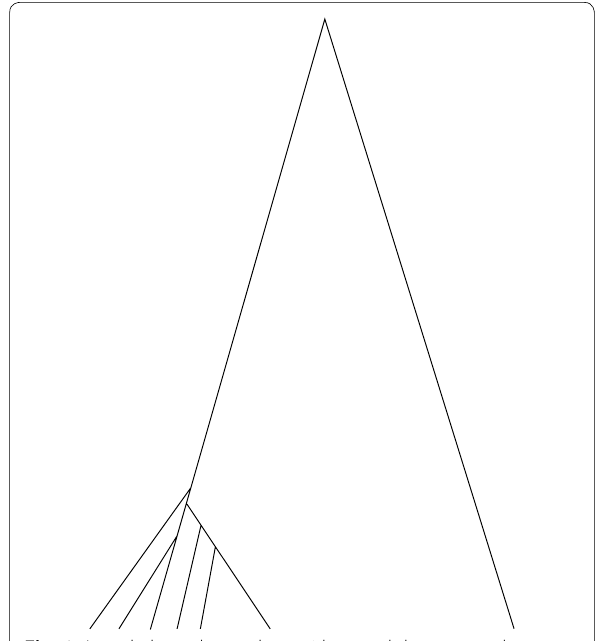
Fig. 6 An unbalanced genealogy with several short external branches can generate extreme values for a multitude of neutrality